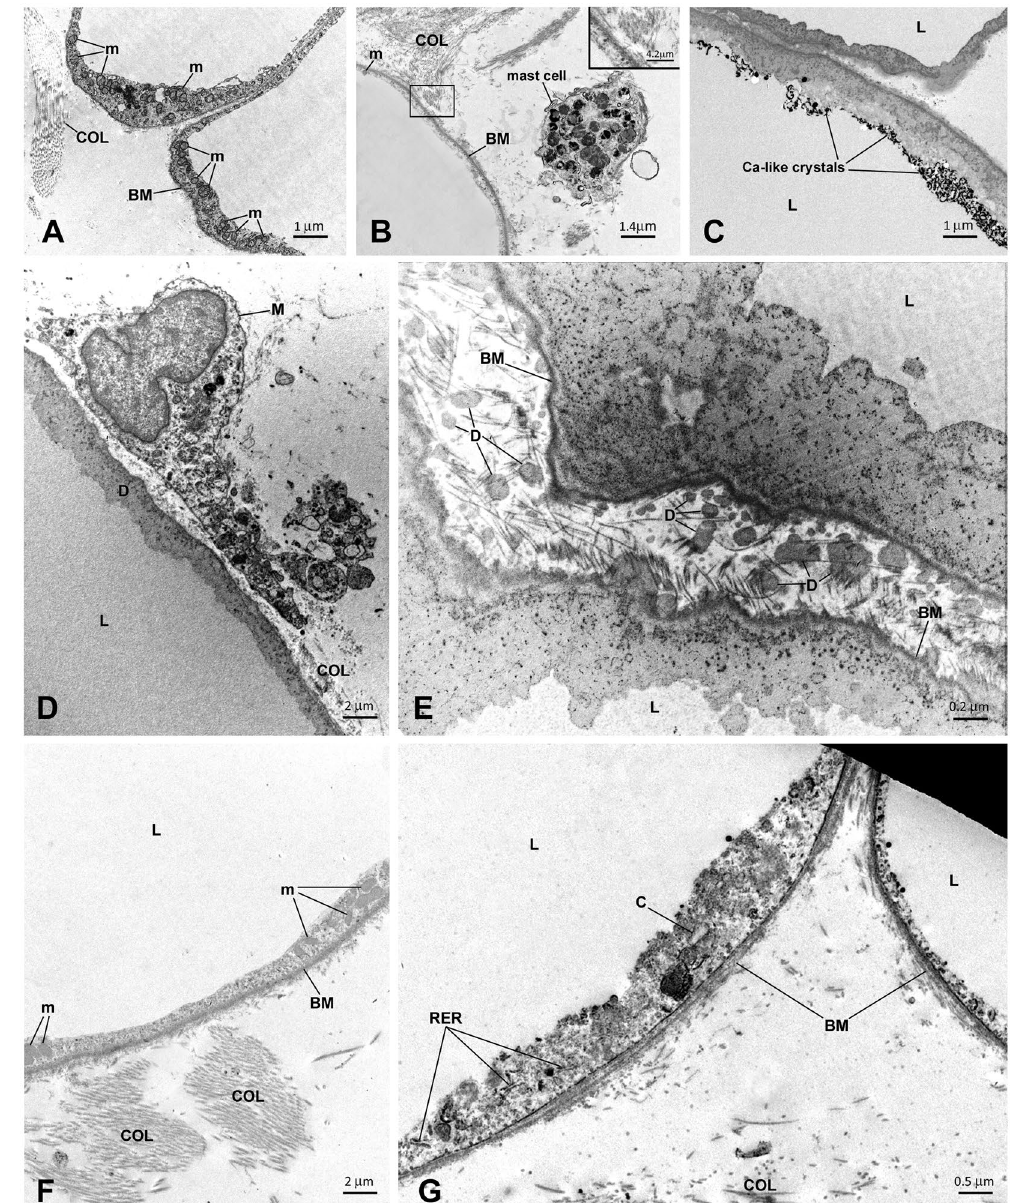
Figure 4. In A , B and C electron microscopy of visceral fat. ( A ) Visceral fat of a lean control subject. ( B ) Visceral fat of an obese non-diabetic (ND) patient. Note the different thickness of the cytoplasmic rim, small and rare mitochondria and abundant collagen (enlarged in the inset) in the obese patient. A mast cell is close to the adipocyte of the obese patient. ( C ) Visceral fat of a T2D patient. The cytoplasm of two degenerating adipocytes is visible. Note the presence of calcium-like crystals in one adipocyte. In D and C electron microscopy of subcutaneous adipose tissue (SAT) of two obese patients with type 2 diabetes. ( D ) Degenerative signs (D) and a close-by macrophage in the interstitium (M). ( E ) The cytoplasm of two degenerating adipocytes is visible. The lipid droplet (L) and basal membrane (BM) are still distinguishable, but the cytoplasm and organelles are not recognizable and are mixed with a dark material that seems to overlay the basal membrane and occupy the interstitium in the form of irregular dots (D) with the same electrondensity of the degenerating cytoplasm. Overall, the fine morphology is compatible with that of degenerating adipocytes (Cinti S et al . 6 . In F and G electron microscopy of subcutaneous adipose tissue (SAT) of two obese patients with type 2 diabetes post-surgery. ( F ) The cytoplasmic rim is thicker than pre-surgery ( cfr , E ) and clusters of mitochondria (m) are visible. BM = basal membrane, COL = collagen fibrils. ( G ) In this adipocyte (left), signs of stress were present: dilated rough endoplasmic reticulum (RER), cholesterol crystals (C), and thick basal membrane (BM). L = lipid droplets, m = mitochondria, BM = basal membrane, COL = collagen fibrils. 196 × 297 mm (150 × 150